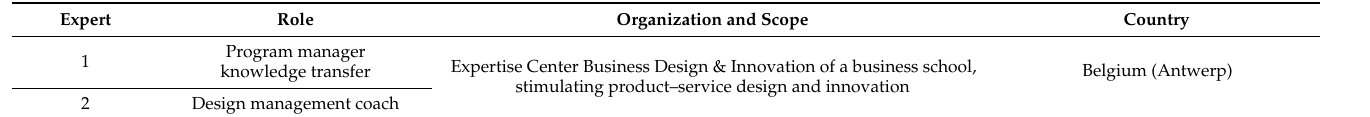
Table 2. Interviewed